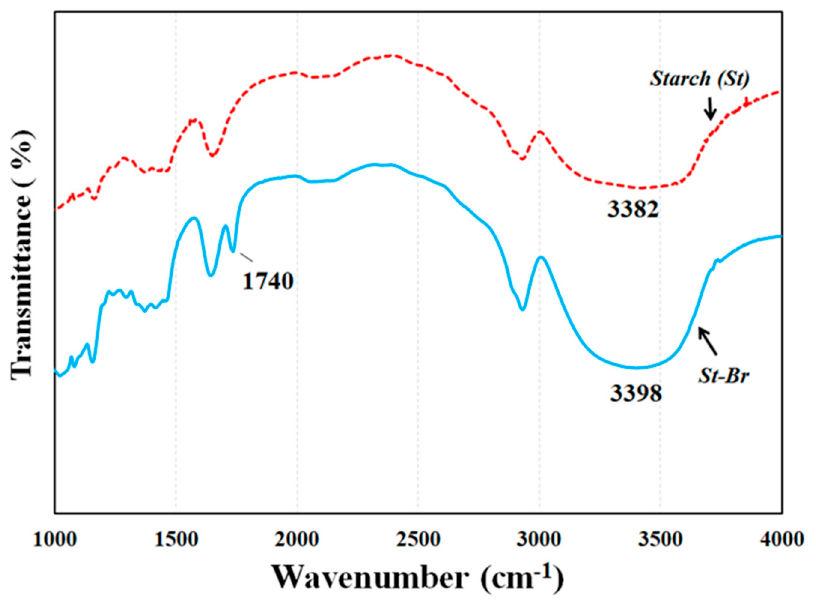
Figure 2. FTIR spectra of starch (St) and starch based macroinitiator (St ‐ Br).